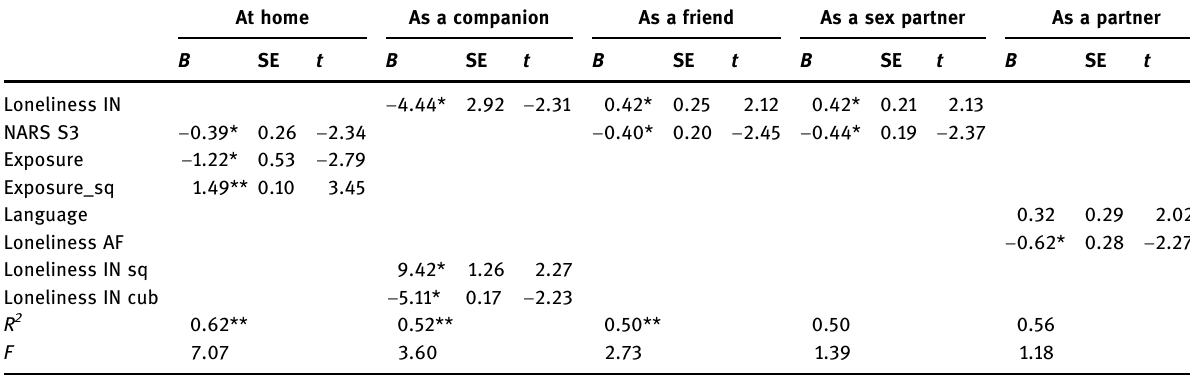
Table 7: Factors predicting Wish to have a robot as a friend, as a companion, as a sex partner, at home, and as a partner At home As a companion As a friend As a sex partner As a partner